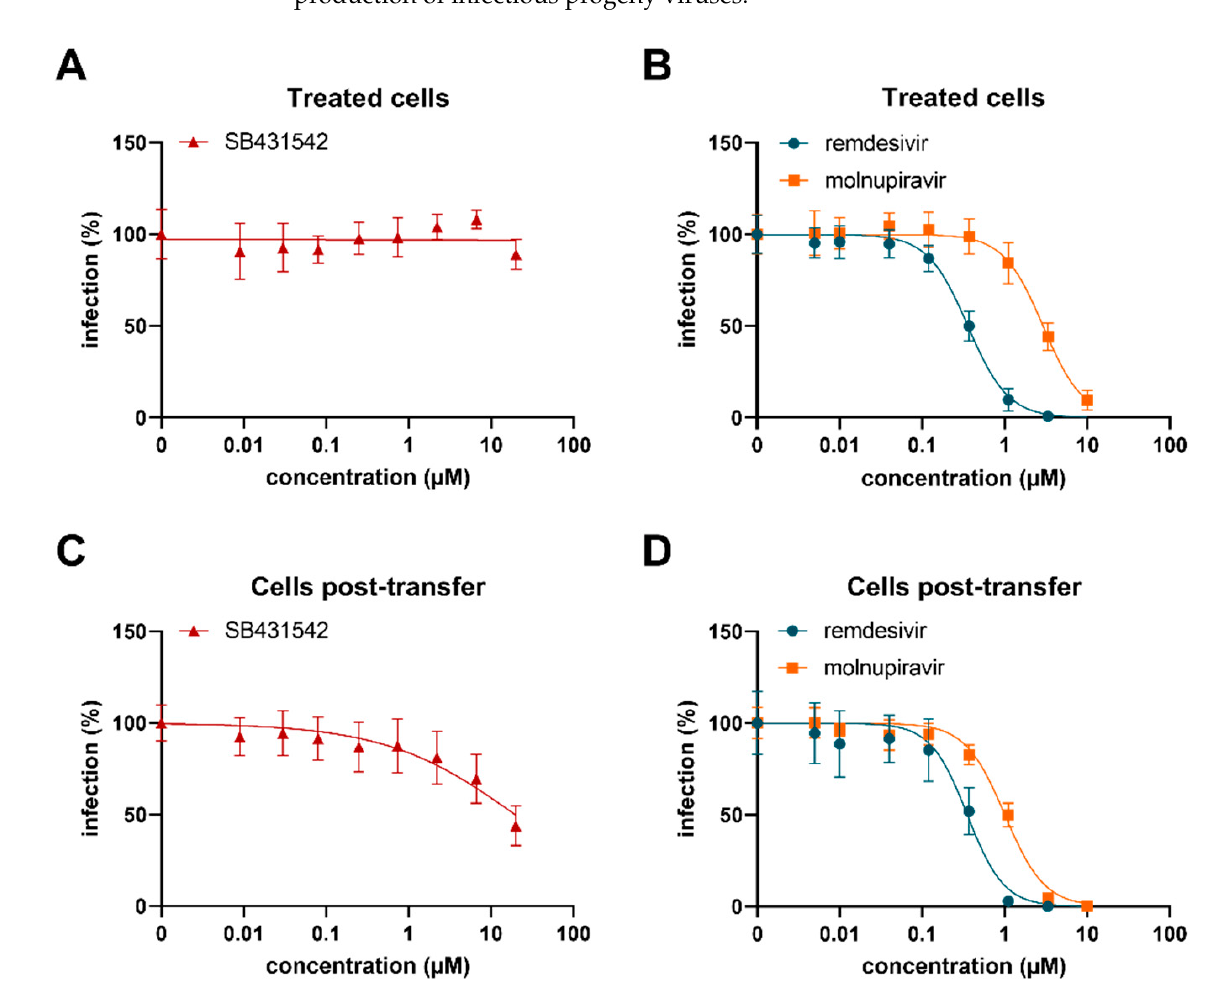
Figure 7. SB431542 reduces infectious virus production. ( A , B ) Calu-3 cells were treated with SB431542, remdesivir, or molnupiravir and infected with SARS-CoV-2 Delta at an MOI of 0.0005. Infection rates were determined two days post infection by in-cell ELISA targeting nucleocapsid. ( C , D ) Supernatants of ( A ) and ( B ) obtained two days post infection were transferred to non-infected Calu-3 cells. Infection rates were measured one day later by in-cell ELISA. Values shown represent